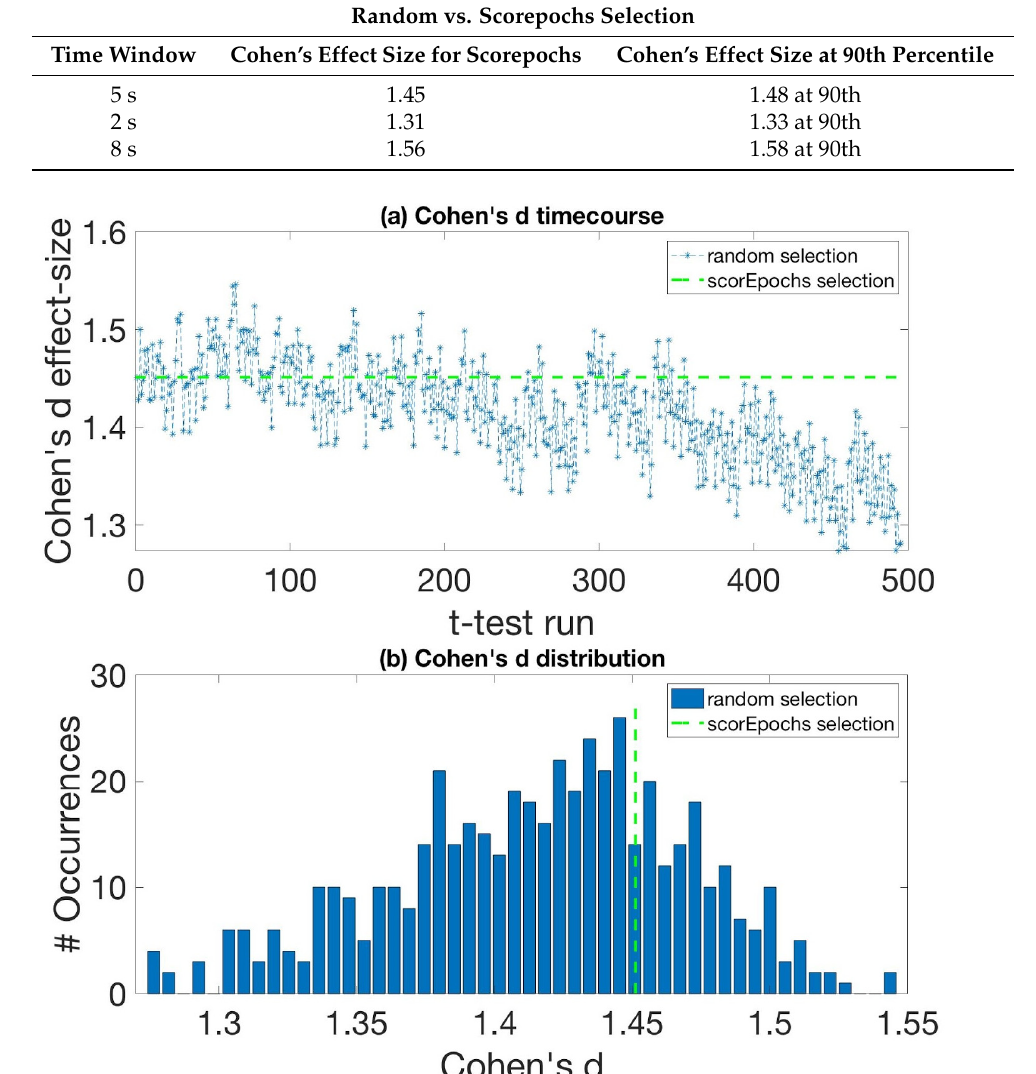
Table 1. The statistics for all comparisons between random and Scorepochs selections. Random vs. Scorepochs Selection